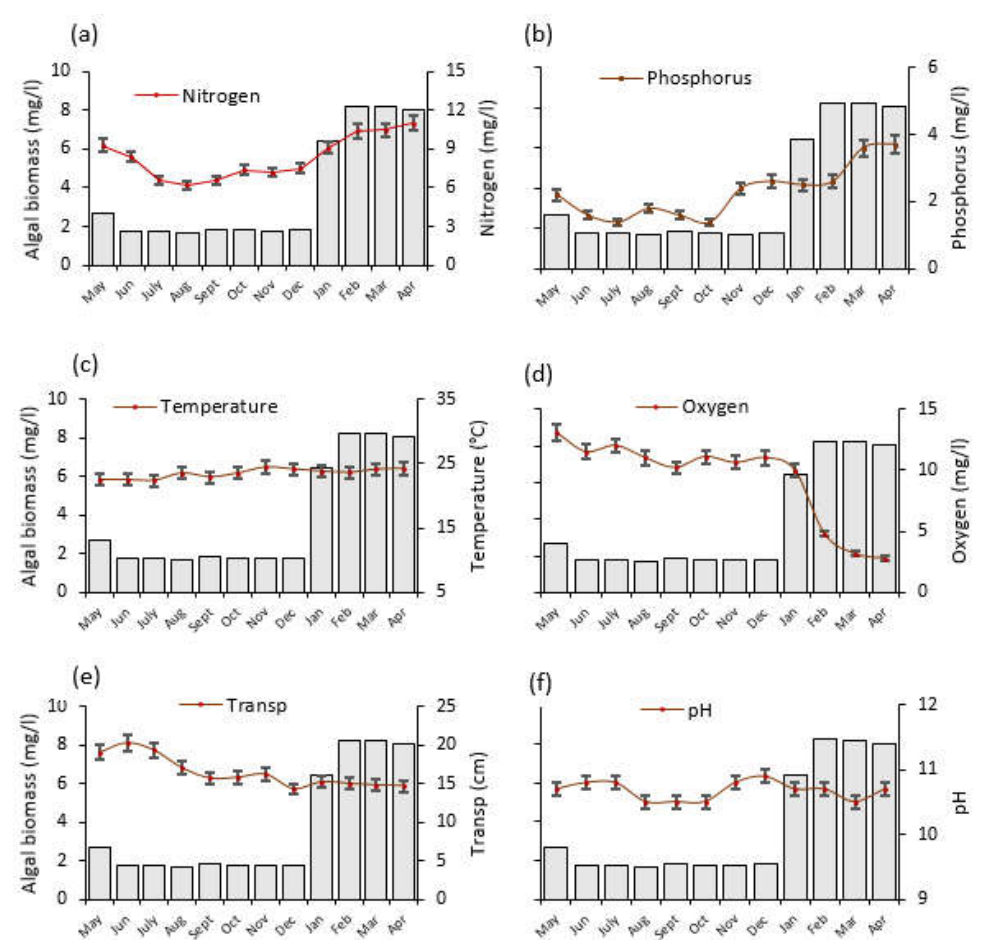
Figure 5. The temporal trends of average ( ± SE) physico–chemical water quality parameters and algal biomass as monitored from May 2020 to April 2021 at Lake Rishateni, northern Tanzania; ( a ) Nitrogen, ( b ) Phosphorus, ( c ) Temperature, ( d ) Oxygen = dissolved oxygen ( e ) Transp = water transparency and ( f ) pH. Please note that the left y-axis denotes algal biomass (mg/l), indicated by gray bars, for all panels.